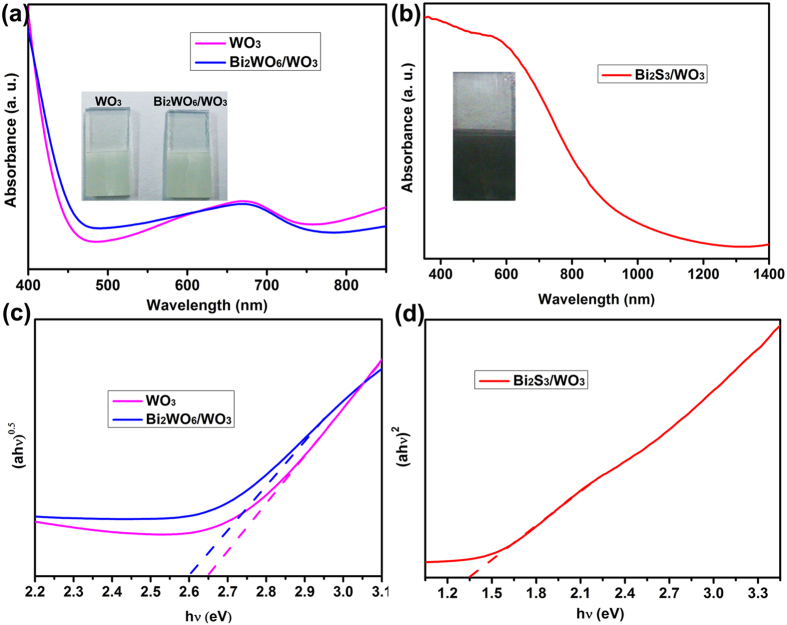
(a,b) UV−vis and Vis-NIR absorption spectra of the WO3, Bi2WO6/WO3 and Bi2S3/WO3 films. (c,d) Tauc plots of the WO3, Bi2WO6/WO3 and Bi2S3/WO3 films.